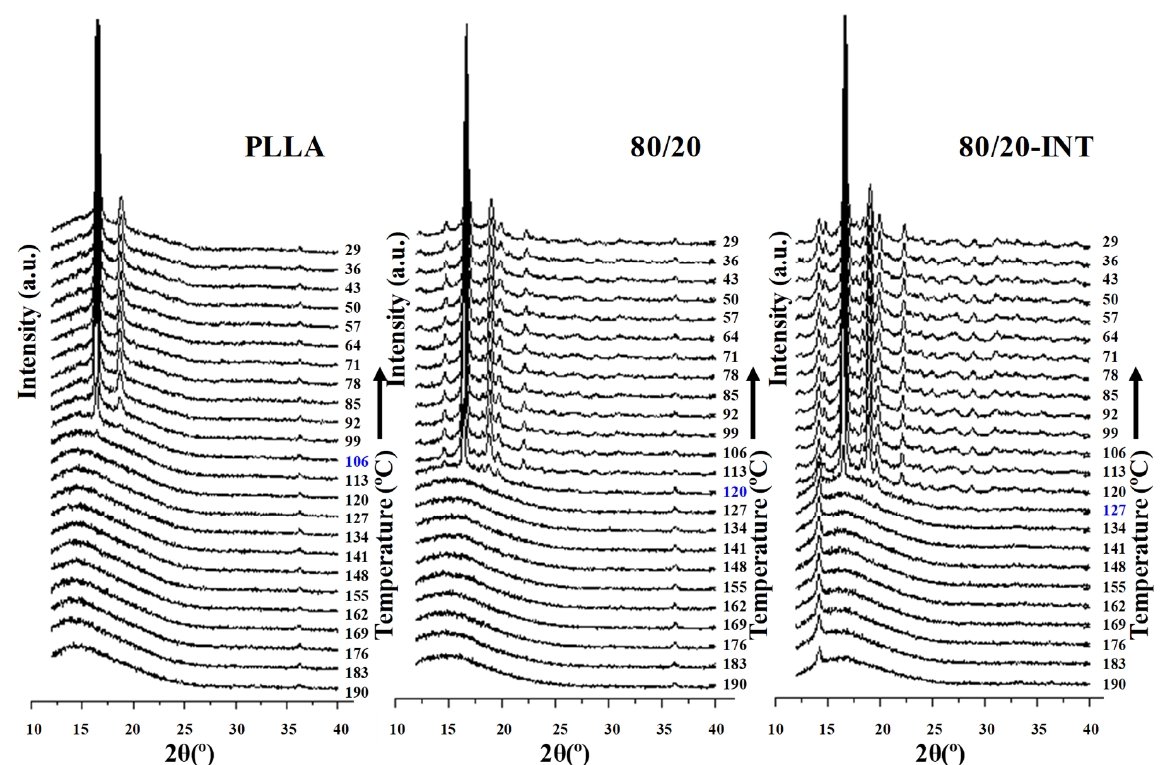
Figure 8. WAXS diffractograms of the dynamic crystallization of PLLA, PLLA/PVDF (80/20), and PLLA/PVDF/INT-WS 2 (80/20-INT) nanocomposites.